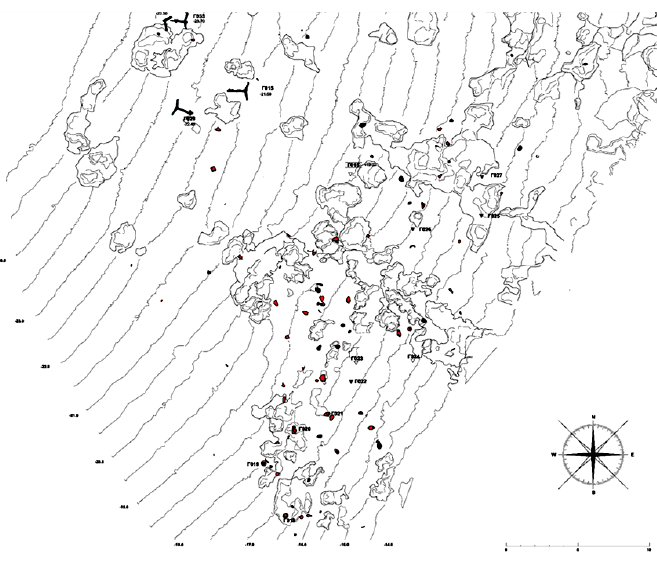
Figure 10: Detailed plan of one of the concentrations (©H.I.M.A.